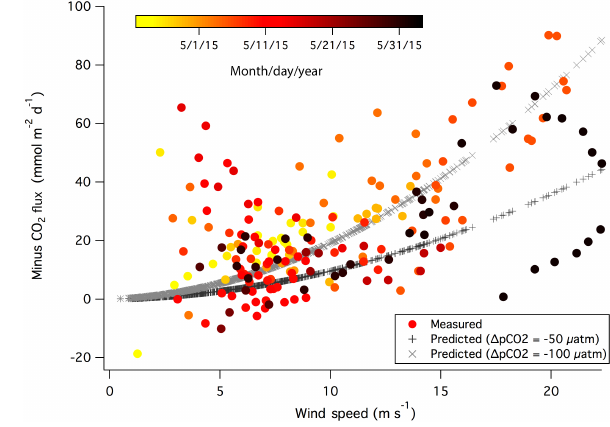
Figure 12. Mean CO 2 and CH 4 cospectra over about half a day for 24 April (wind speed of 8ms − 1 ) and 10 May 2015 (wind speed of 6ms − 1 ) . Measurements were made at 18ma.m.s.l. and from the south-westerly direction. Theoretical spectral fits (Kaimal et al., 1972) are also shown.